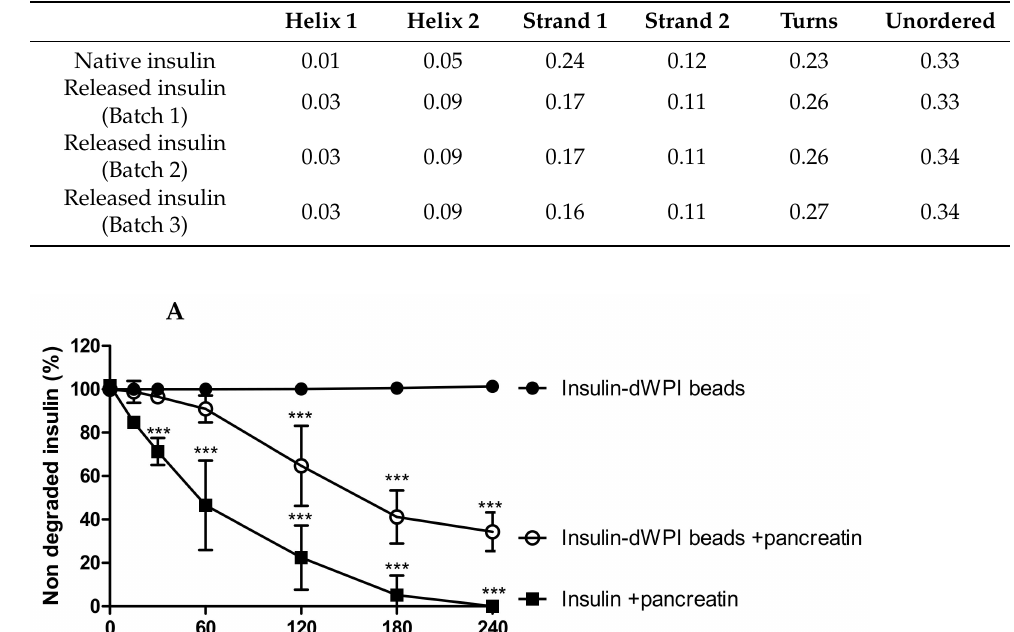
Table 3. The secondary structure fractions as calculated by CDSSTR ® software.